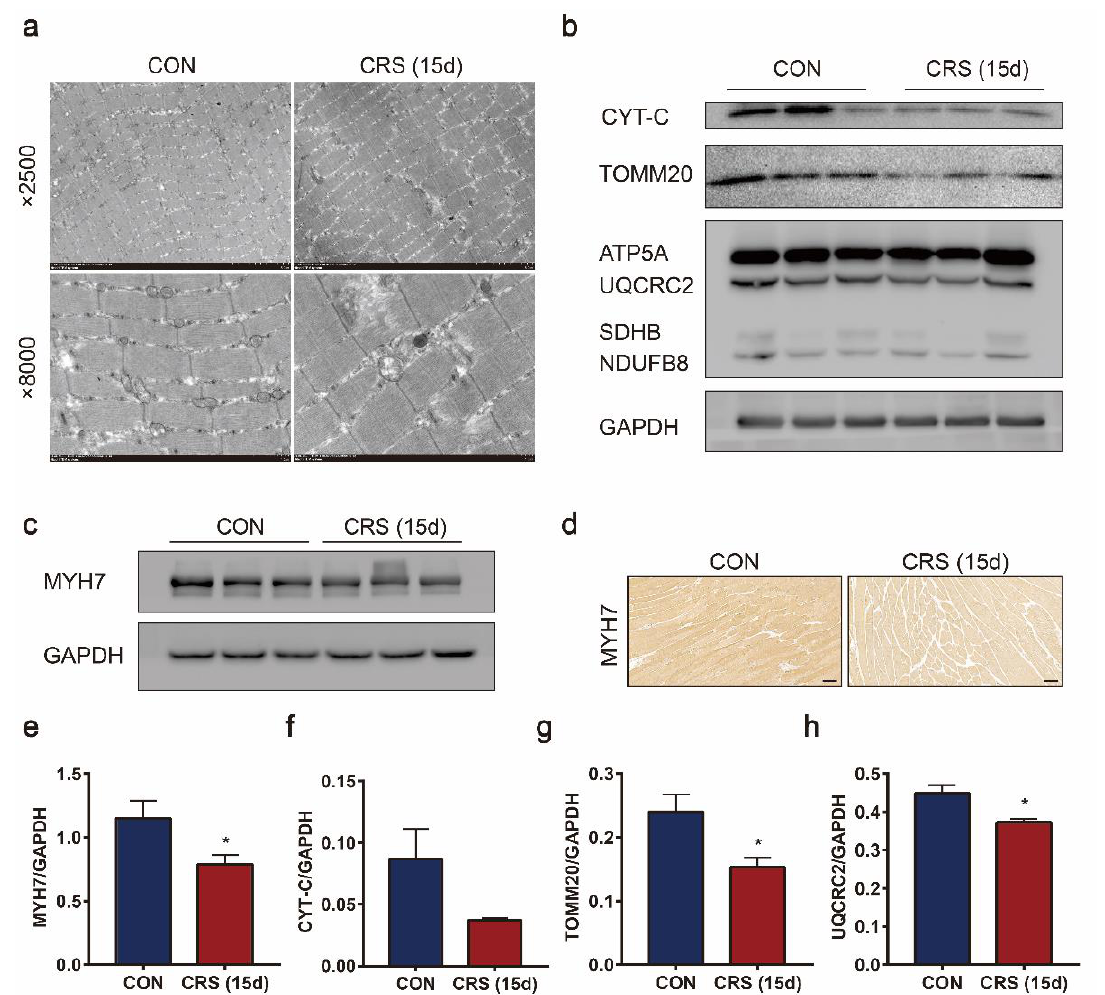
Figure 5. Effects of CRS on mitochondrial dysfunction in the muscle of mice. Electron micrographs of the CON and CRS gastrocnemius muscles ( a ). Immunoblotting of CTT-C, TOMM20, OXPHOS ( b ) and MYH7 ( c ) in the gastrocnemius muscle. Representative images of immunohistochemical staining for MYH7 ( d ) of the CON and CRS gastrocnemius muscles (scale bar = 100 μm). And the quantification of MYH7 ( e ), CTT-C ( f ), TOMM20 ( g ), and UQCRC2 ( h ) protein expression. Data are presented as the mean ± SEM (n = 3), * p < 0.05.